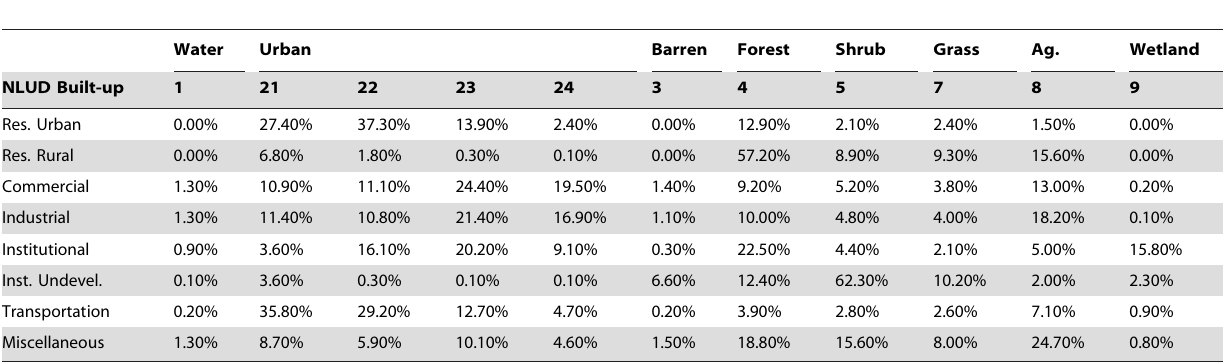
Table 5. A comparison of the National Land Use database (2010) against the National Land Cover Dataset (2006) for built-up uses.